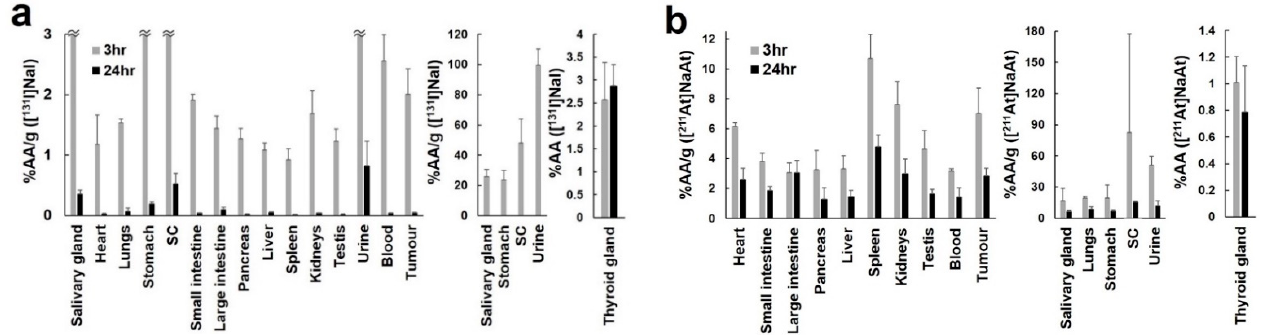
Figure 3. Biodistribution of [ 131 I]NaI ( a ) and [ 211 At]NaAt ( b ) solution at 3 and 24 h postadministration in the K1-NIS xenograft mice. The percent administered activity (%AA) of the thyroid gland and %AA/g of other organs are expressed as mean ± standard deviation. %AA/g of 131 I in the salivary gland, stomach, stomach contents, and urine at 3 h and %AA/g of 211 At in the salivary gland, lungs, stomach, stomach contents and urine are shown separately. SC, stomach contents.